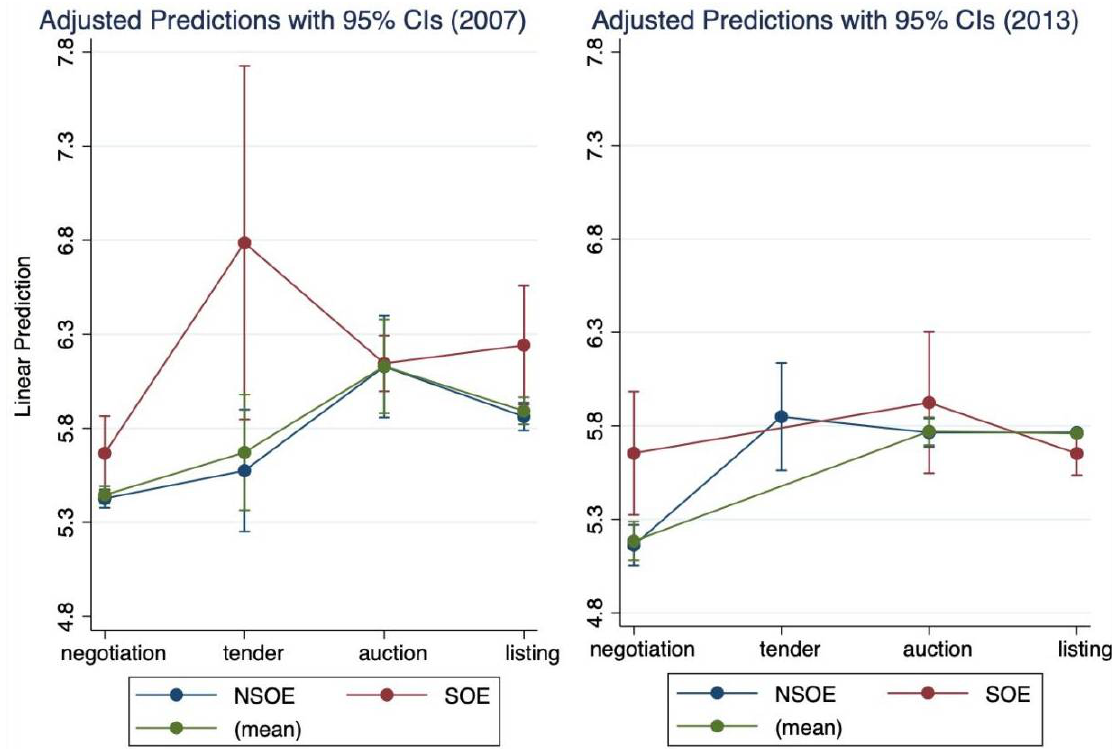
Figure 3. Average marginal effect of cross-products of types of enterprise ownership and transfer modes on land purchase prices in 2007 and 2013. SOE, state-owned enterprise; NSOE, non-state-owned enterprise. Sample size of industrial land transferred through bidding is too small, which makes it impossible to estimate the average marginal effect of state-owned enterprises under this transfer method, but this does not affect the analysis results of the other transfer methods. Only samples of negotiation, auction, and listing are included in this paper, and the results are consistent here.